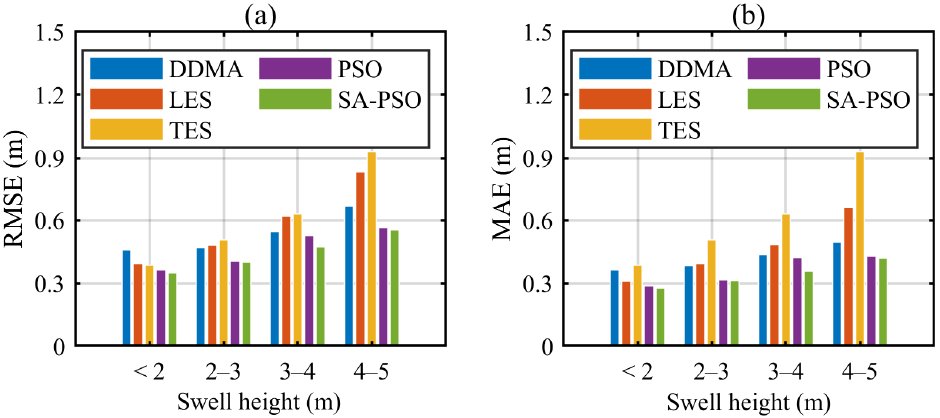
Figure 10. ( a ) RMSE and ( b ) MAE for different ranges of the GNSS-R swell